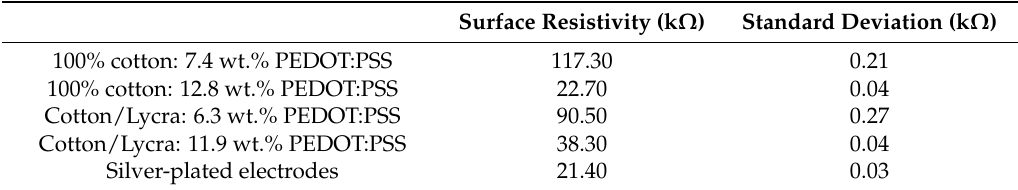
Table 3. Comparison of surface resistivity of textile electrodes after increasing wt.% PEDOT:PSS. Surface Resistivity (k Ω